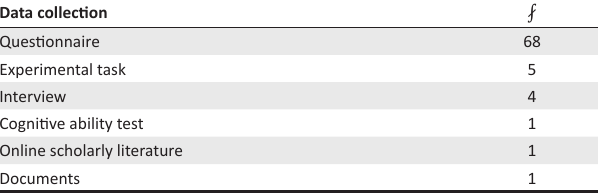
TABLE 5: Data collection method frequency.